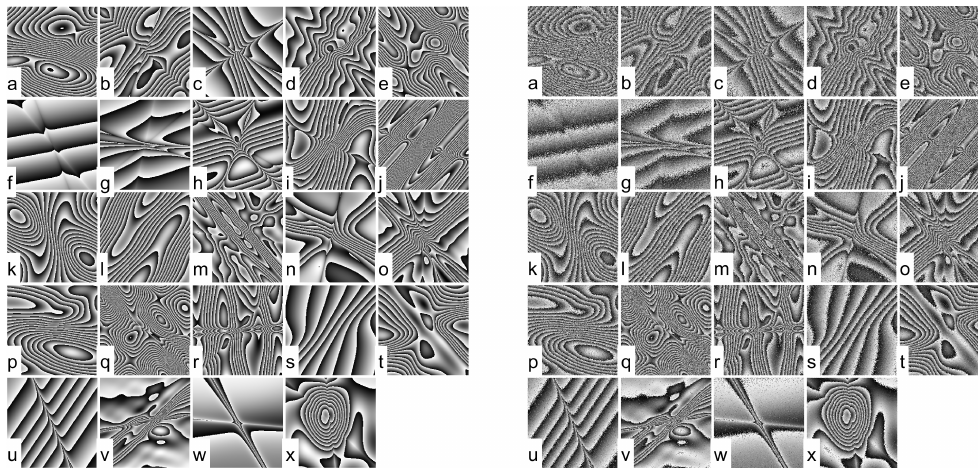
Figure 1. Phase maps of DB128-test. On the left , the 24 noise-free phase maps from ( a – x ), on the right , from ( a – x ) corresponding to 24 noisy phase maps with increasing input SNR.